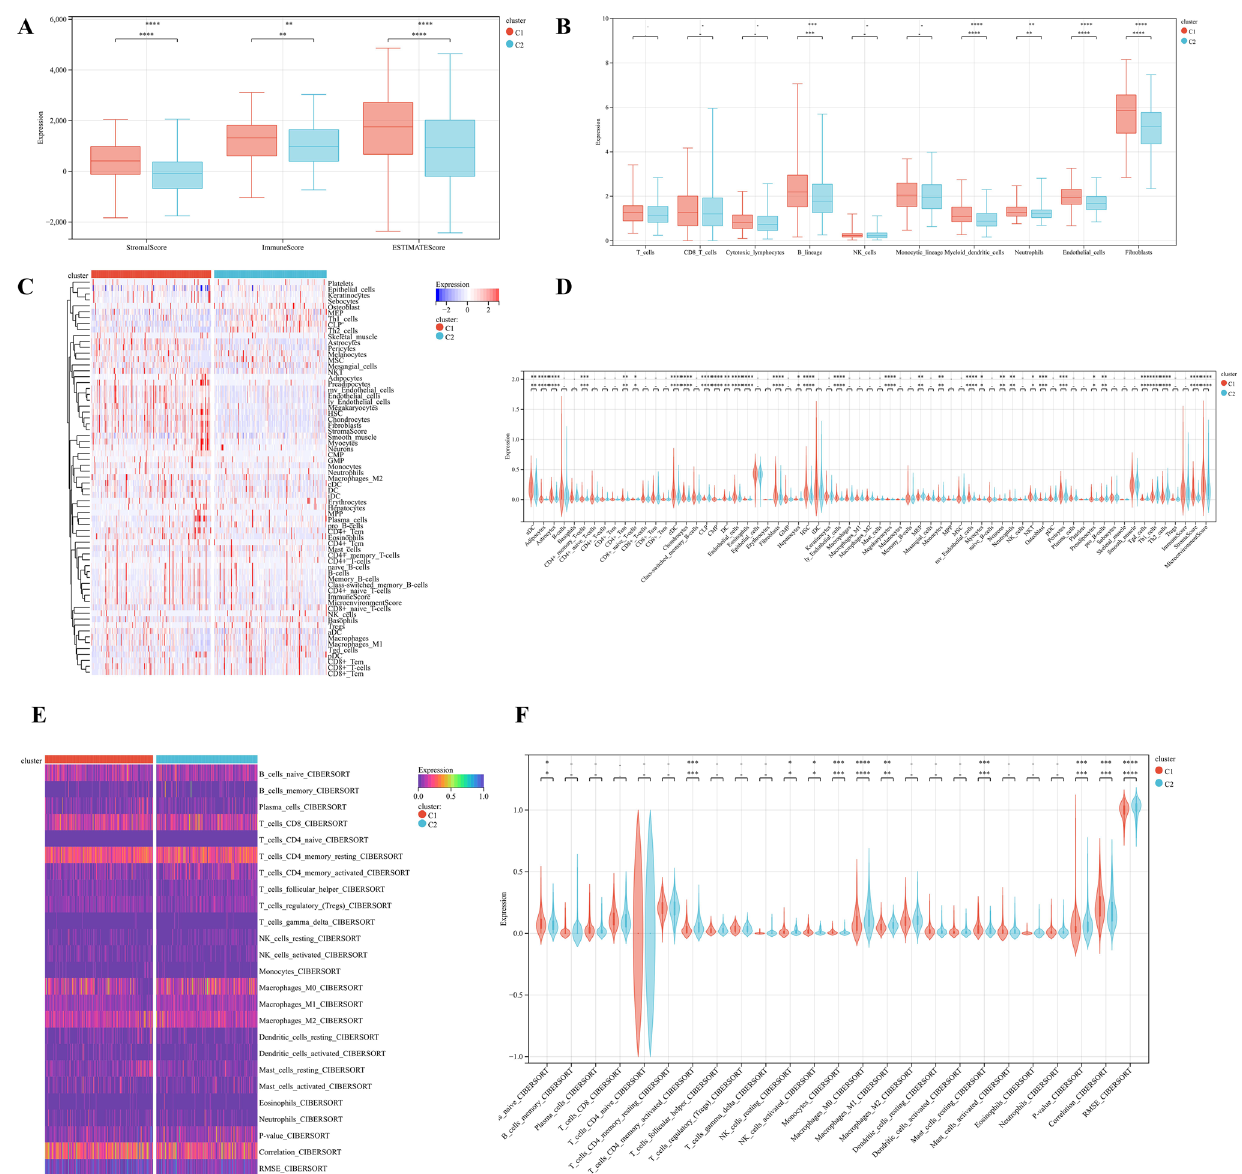
Figure 3. Immune analysis of two molecular subtypes. ( A ) Stromal score, Immune score, ESTIMATE score and calculated by ESTIMATE algorithm (* p < 0.05; ** p < 0.01; *** p < 0.001). ( B ) Abundance of ten immune filtrating cells evaluated by MCPcounter algorithm (* p < 0.05; ** p < 0.01; *** p < 0.001). ( C ) Heatmap depicting the enriching level of immune related cells evaluated by TIMER. ( D ) Statistical analysis of immune related cells evaluated by TIMER (* p < 0.05; ** p < 0.01; *** p < 0.001). ( E ) Heatmap depicting the enriching level of 25 immune related cells evaluated by CIBERSORT algorithm. ( F ) Statistical analysis of 25 immune related cells evaluated by CIBERSORT algorithm (* p < 0.05; ** p < 0.01; *** p < accurate prediction ability within 5 years, with AUC of 0.69, 0.80 and 0.81 for 1, 3 and 5 years (Fig. 4E). Finally, the TIME of the two groups was evaluated using the ESTIMATE algorithm, and the results showed that the high risk group had a higher ESTIMATE score ( P = 1.2e−4), higher Immune score ( P = 4.8e−7), and higher Stromal score ( P = 5.1e−7) (Fig. 4F). The TIMER database was used to predict the relationship between the FRPGs and the infiltration level of immune cells, and it was found that the FRPGs were closely related to the infiltration of macrophages, B cells, T cells, dendritic cells, and neutrophils (Fig. 4G). The CIBERSORT algorithm indi- cated that Macrophases-M1 ( p < 0.01) and Macrophases-M2 ( p < 0.001) were significantly higher in high risk groups than in low risk groups, while Dendritic-cells-activated was significantly higher in low risk groups than in high risk groups (Fig. 4H), suggesting the TIME and immune status of the two groups differed significantly. These results indicated that the risk signature constructed had a strong potential for prognosis prediction of GC patients, and it was significantly correlated with TIME in GC. The HPA database examined the immuno- histochemical (IHC) staining of FRPGs (Fig. 5A–J), and found that the protein expressions of ZFP36, TUBE1,